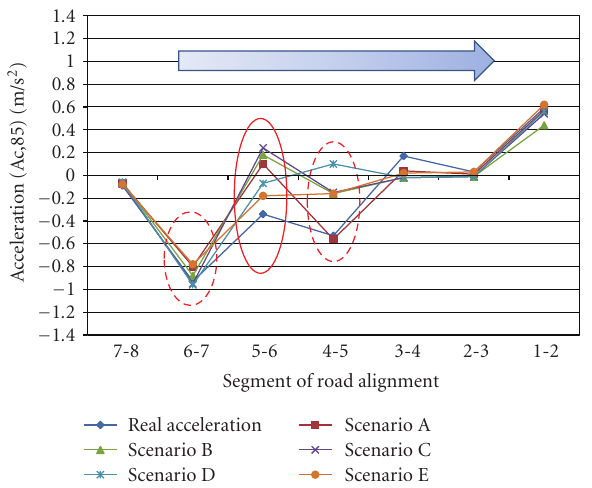
Figure 11: Profile of the accelerations in the di ff erent driving environments, westbound